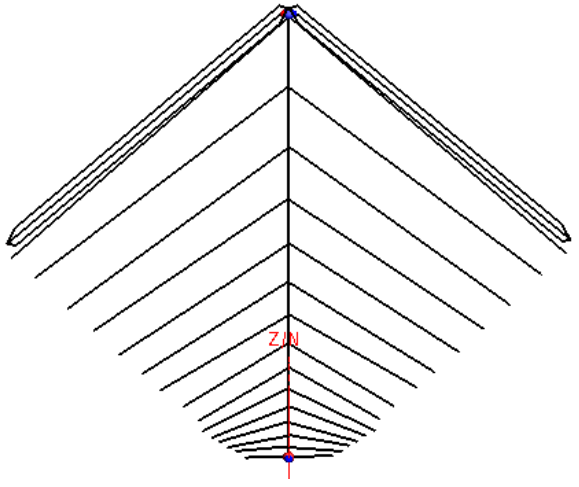
Figure 5. The simulation model.